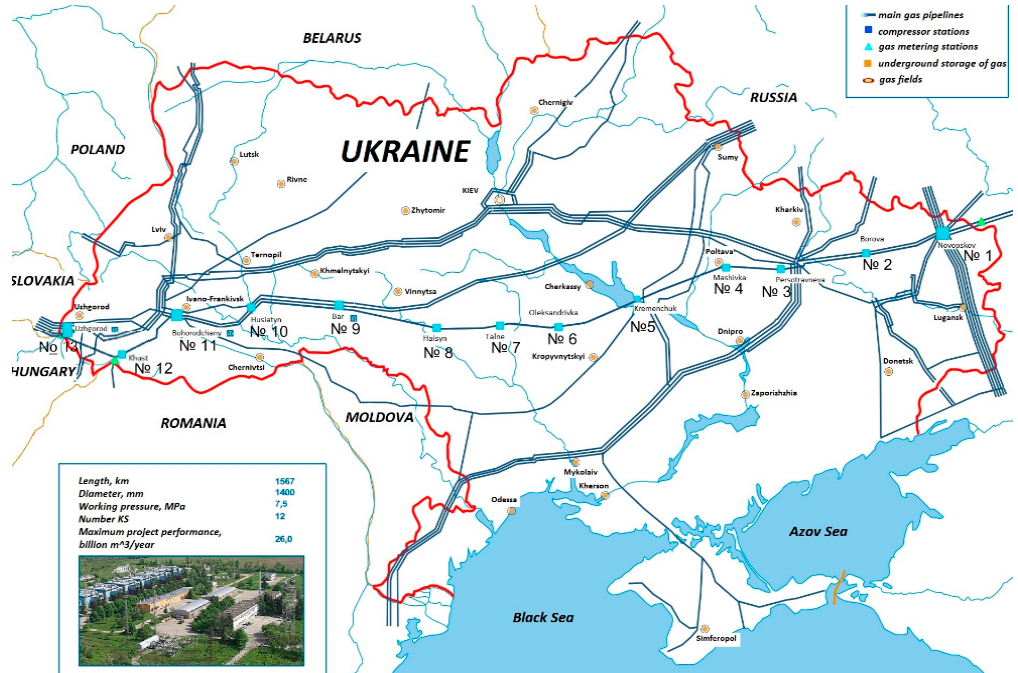
Figure 4. The GTS of Ukraine with the designated “Soyuz” gas main with a total length of 1567.3 km (the territory of Ukraine), a diameter of 1420 mm, and a wall thickness of 20 mm, which has 13 compressor stations (CS) equipped with GTK-10I gas-pumping units along its route: 1. Novopskov; 2. Borova; 3. Pershotravneva; 4. Mashivka; 5. Kremenchuk; 6. Oleksandrivka; 7. Talne; 8. Haisyn; 9. Bar; 10. Husiatyn; 11. Bogorodchany; 12. Khust; 13. Uzhgorod.